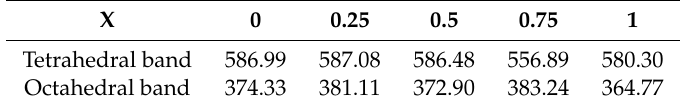
Table 2. Vibrational frequencies corresponding to tetrahedral and octahedral metal complexes.